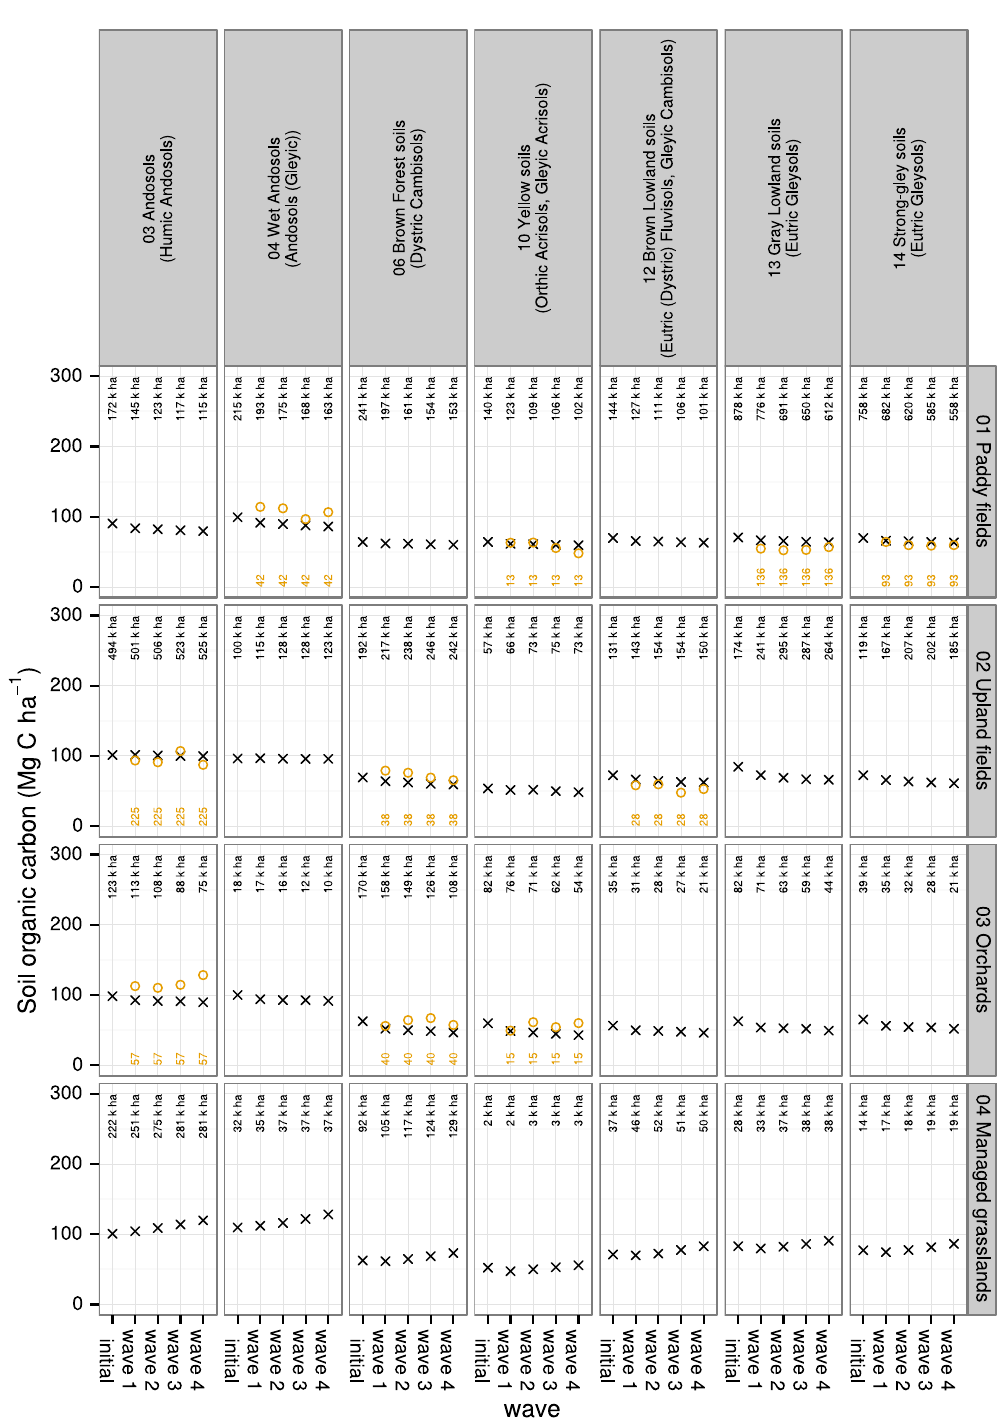
Figure 7. Temporal changes in the weighted mean concentration of soil organic carbon (SOC) calculated for seven major soil groups (lined- up horizontally) under different land-use types (lined-up vertically) in agricultural lands in Japan. Simulated SOC stock (black cross) were superimposed on observed data from the Basic Soil Environment Monitoring Project, stationary monitoring conducted during 1979–1998 (ocher circle). Black figure labels above black cross indicate area of land accounted for in the calculation of the weighted mean concentration of simulated SOC, in unit of kilo hectare. Ocher figure labels below ocher circle indicate number of samples used to calculate the weighted mean concentration of SOC in the monitoring. Relative area distribution of soil groups are as follows: 03 Andosols – 21%, 04 Wet Andosols – 7%, 06 Brown Forest Soils – 14%, 10 Yellow Soils – 5%, 12 Brown Lowland Soils: 7%, 13 Gray Lowland Soils: 22%, 14 Gley Lowland Soils – 17%. Years of each survey wave (horizontal axis in each plot) are as follows: initial – 1970, wave 1 – 1979–1983, wave 2 – 1984–1988, wave 3 – 1989–1993, wave 4 –